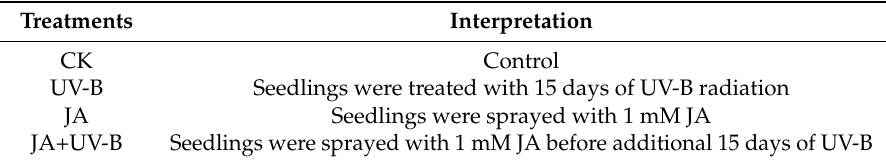
Table 4. The different treatments conducted in the